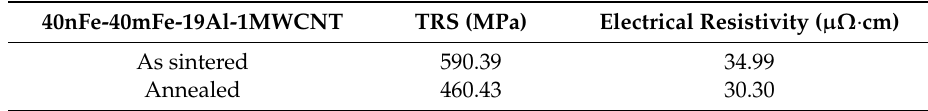
Table 6. E ff ect of post-sintering annealing on transverse rupture strength (TRS) and electrical resistivity of 40nFe-40mFe-19Al-1MWCNT